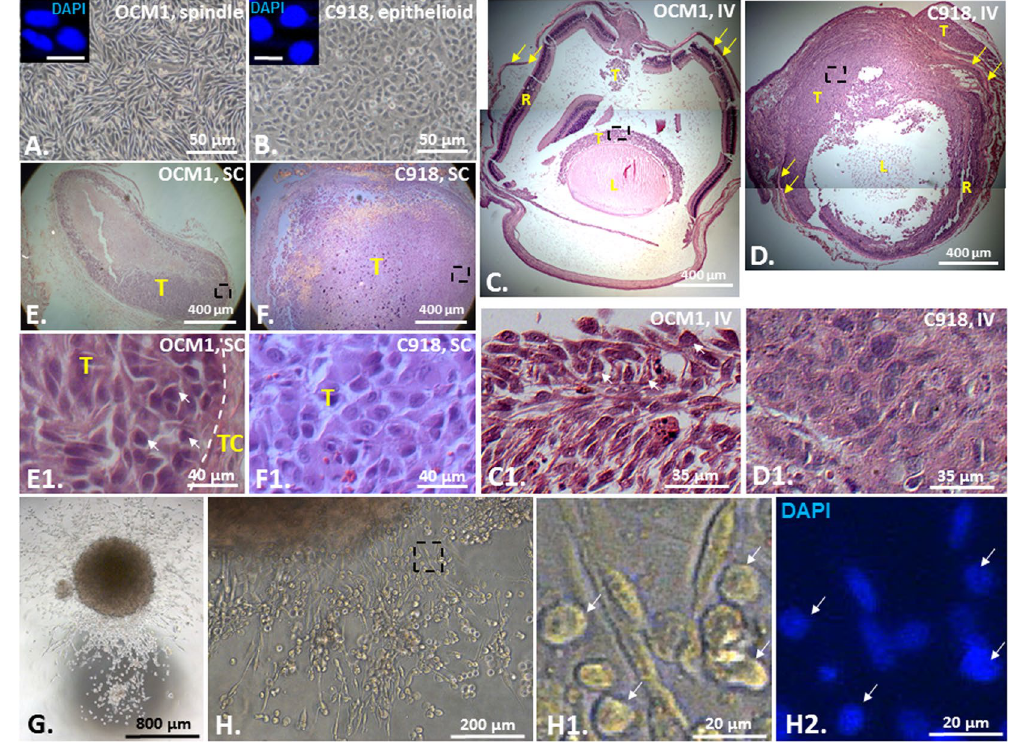
Figure 1. Epithelioid C918-derived tumors are more malignant than spindle OCM1-derived tumors. Confluent monolayer cultures of ( A ) the spindle UM cell line OCM1 and ( B ) the epithelioid UM cell line C918. Scale bar = 10 μ m. Representative H&E stained images of both ( C ) OCM1- and ( D ) C918-derived ocular tumors generated in 13 days after IV injection, and both ( E ) OCM1- and ( F ) C918-derived cutaneous tumors generated in 13 days after SC injection. ( G ) A single OCM1 cell-formed sphere touched down and cells migrated out of the sphere. ( H ) OCM1 sphere-derived polymorphic cell types (inserts) including those with rounded epithelioid/ amoeboid shape (arrows). IV = Intravitreal injection; SC = subcutaneous injection; L = Lens; R = Retina; T = Tumor; TC = Tumor Capsule. Yellow arrows indicate the sclera. White arrows indicate epithelioid cells in the OCM1-derived tumors and from an OCM1 sphere. Black dashed rectangles indicate the bottom-side inserts. Mean (M) ± standard deviation